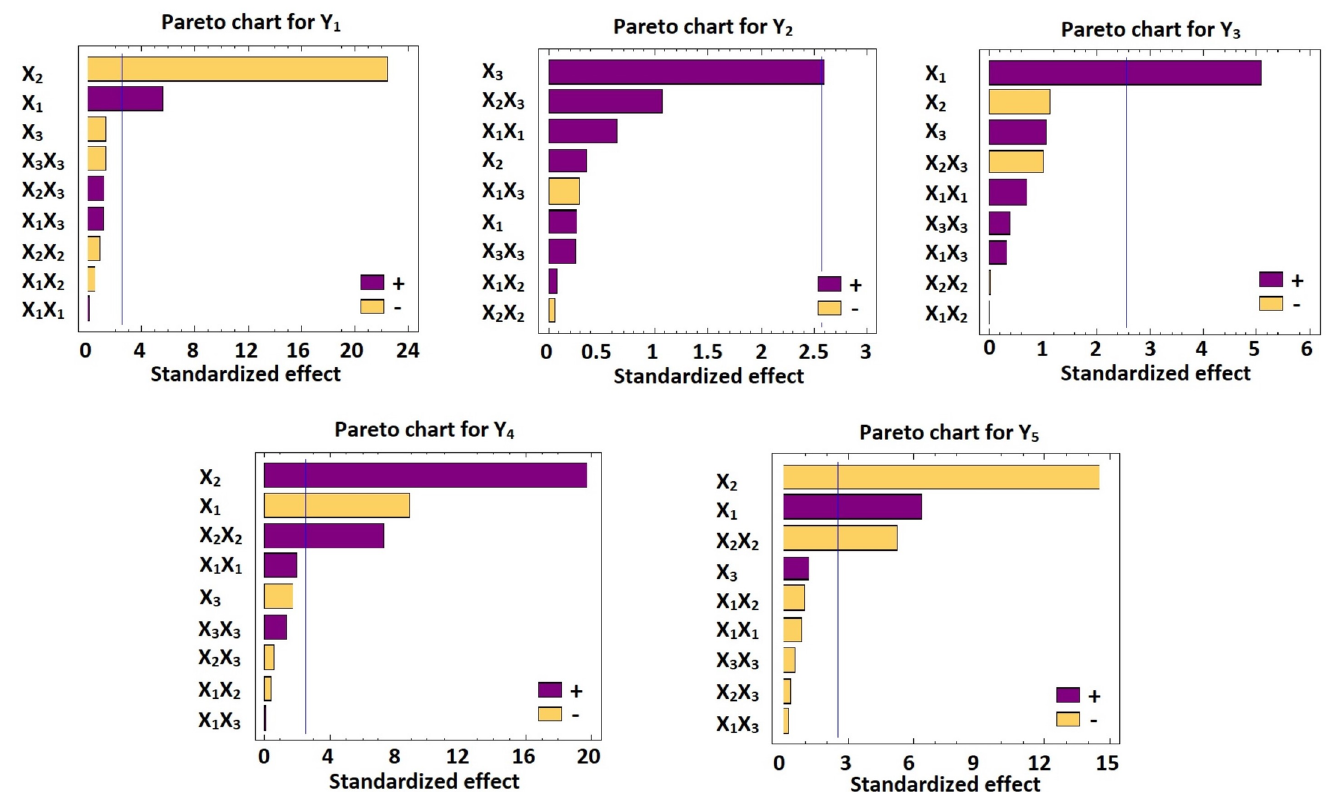
Fig 2. Standardized Pareto charts for Y 1 -Y 5 . Abbreviations: X 1 , Percirol ATO5 concentration; X 2 , Gelucire 44/14 concentration; X 3 , Stearylamine concentration; T85%, time for 85% of drug release; X 1 X 2 , X 1 X 3 and X 2 X 3 are the interaction terms between the factors; X 1 X 1 , X 2 X 2 and X 3 X 3 are the quadratic terms of the factors.